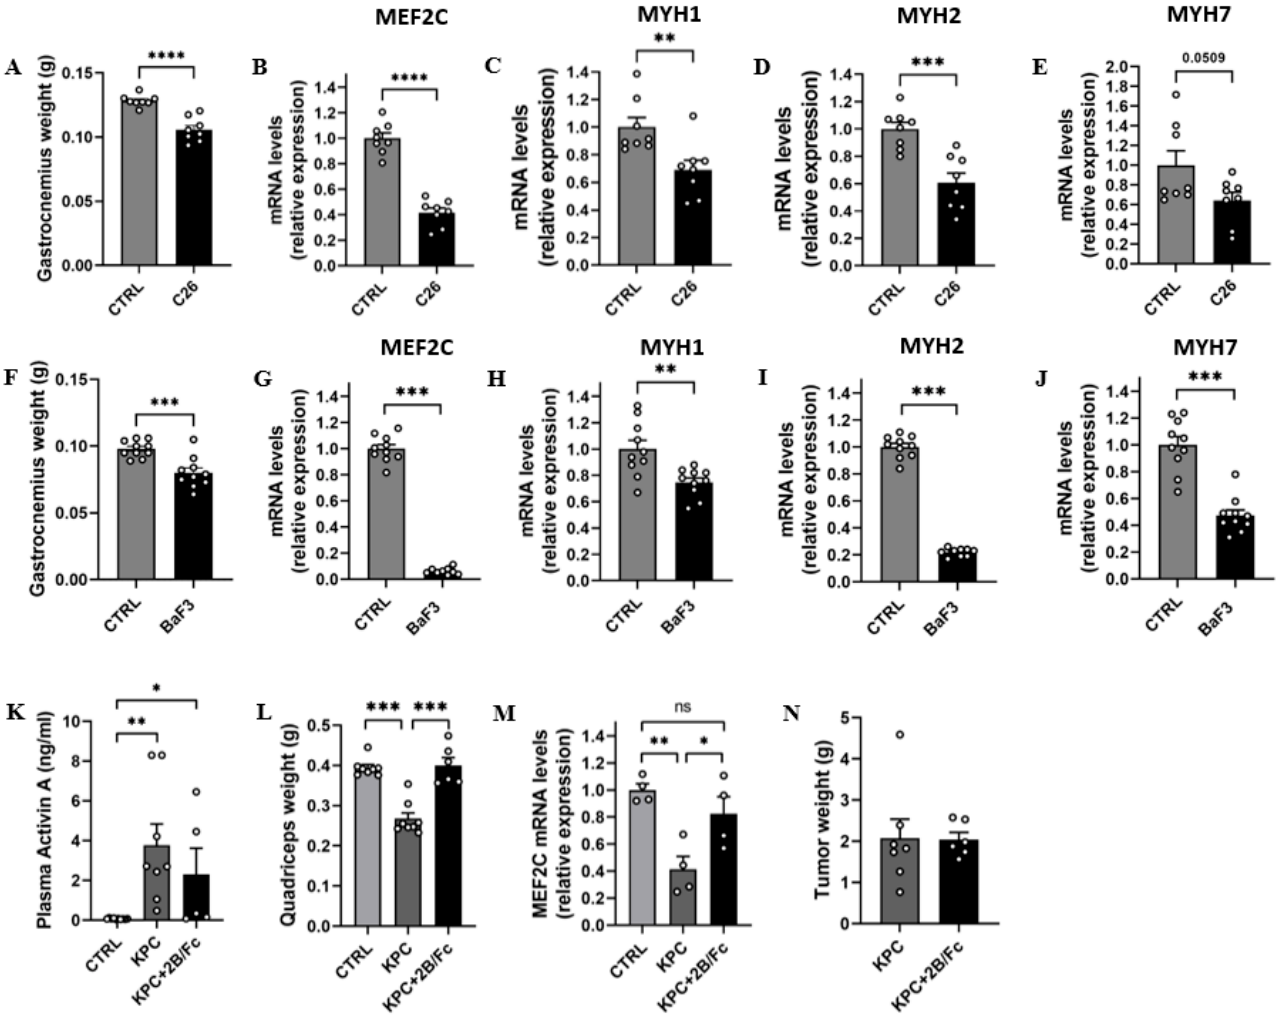
Figure 6. Cancer cachexia is associated with downregulation of muscle MEF2C expression and activity which is blunted by inhibition of activin A. ( A ) Gastrocnemius weight and ( B – E ) muscle MEF2C, MYH1, MYH2, and MYH7 mRNA levels, 11 days after subcutaneous implantation of C26 cells (C26) or saline solution (Ctrl). ( F ) Gastrocnemius weight and ( G – J ) muscle MEF2C, MYH1, MYH2, and MYH7 mRNA levels, 14 days after tail intravenous injection of BaF3 cells (Baf3) or saline solution (Ctrl). ( K ) Plasma ActA levels, ( L ) quadriceps weight, ( M ) muscle MEF2C mRNA levels, and ( N ) tumor weight, in KPC mice treated by ACVR2B/Fc (KPC + 2B/Fc) or phosphate buffered saline (KPC). Data are reported as means ± SEM (n = 4–10/groups). * p < 0.05, ** p < 0.01, *** p < 0.001, and **** p < 0.0001, ns: not significant.